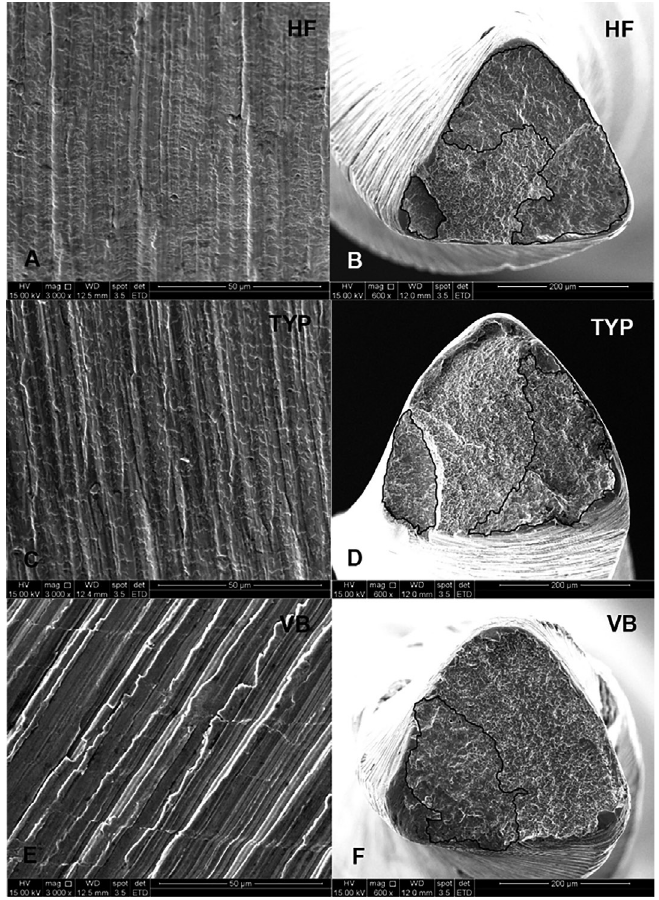
Figure 3- Scanning electron microscopy images of typical lateral surface of cyclic strained instruments (A=Hyflex, C=Typhoon, E=Vortex Blue) and from surfaces that suffered rupture (B=Hyflex, D=Typhoon, F=Vortex Blue) after the cyclic flexural fatigue test (outlined areas correspond to the region of fatigue crack nucleation and